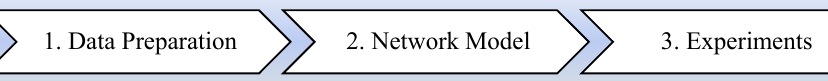
Figure 3. Examples for defect types: ( a ) nondefective; ( b ) hole; ( c ) weave; ( d ) stain; ( e ) thread; ( f ) knitting; ( g ) shaded.